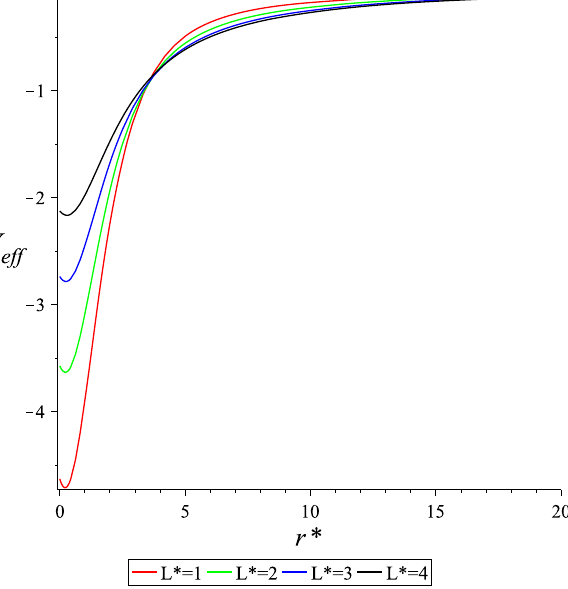
Fig. 5 Effective potentials for timelike particle with E = 1, l ∗ = 2, b ∗ = 0 . 2, and the rotational parameter a ∗ = 0 . 5. The angular momen- tum L ∗ varies from 1 to